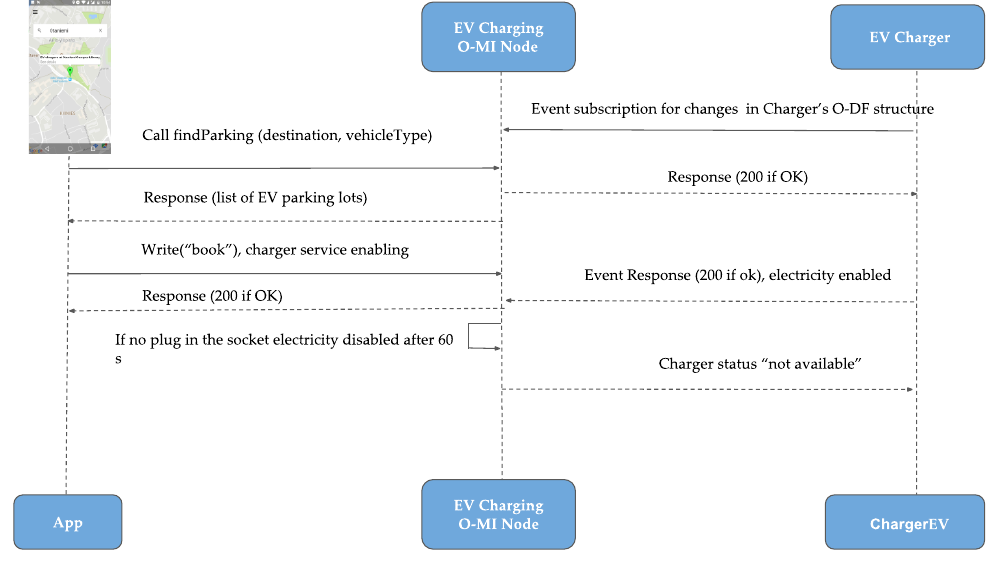
Figure 4. EV charging service sequence diagram.